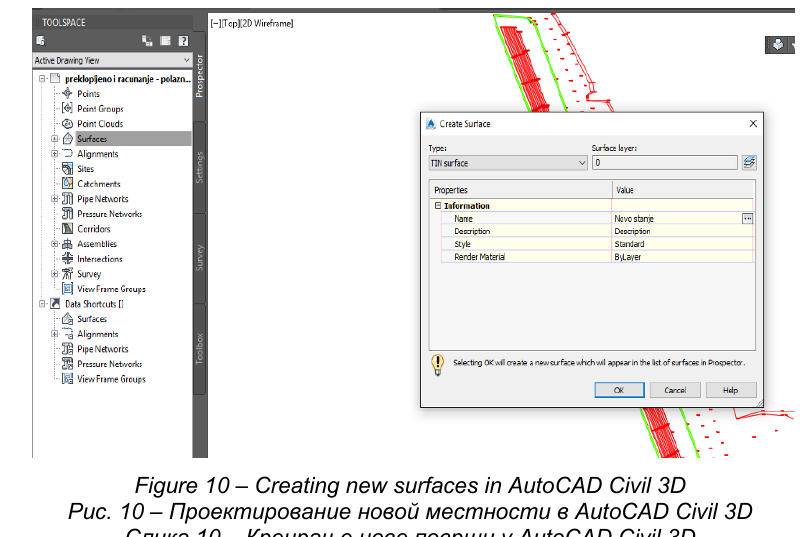
Figure 10 – Creating new surfaces in AutoCAD Civil 3D Рис . 10 – Проектирование новой местности в AutoCAD Civil 3D